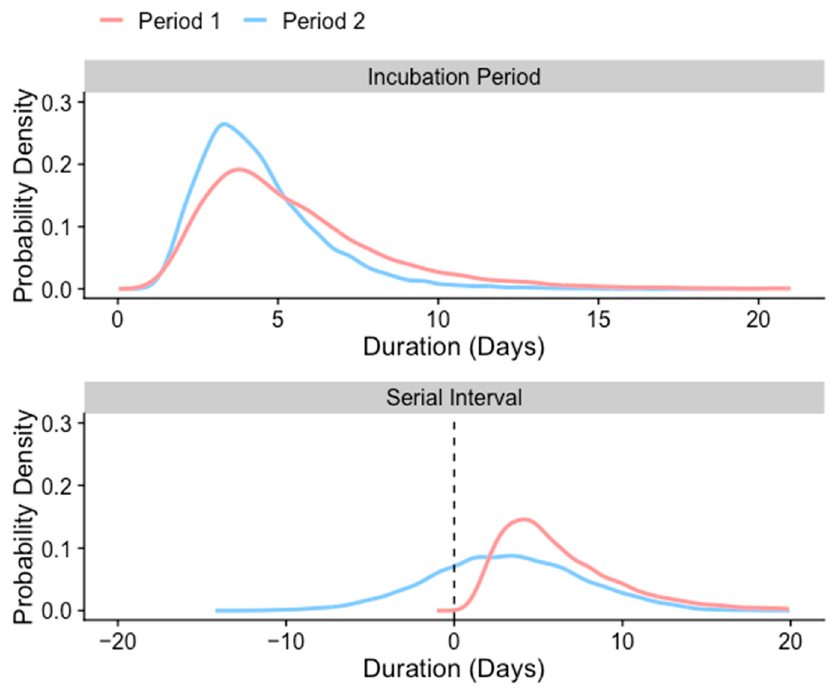
Figure 2. Probability density functions for the reported incubation period and serial intervals based on which the estimates were obtained in this study.